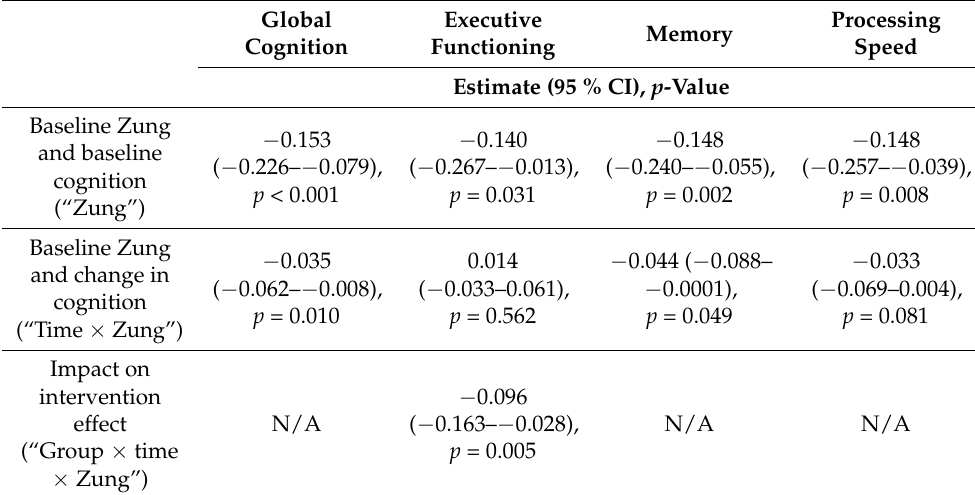
Table 3. The effect of clinically significant depressive symptoms at baseline on change in cognition (results of the best-fitting